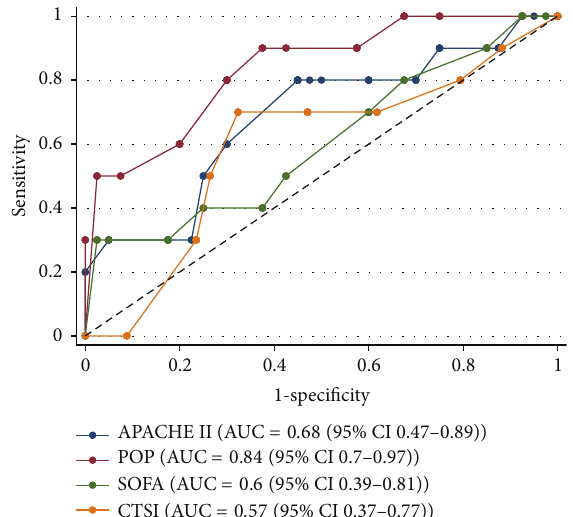
Figure 2: ROC curves for APACHE II, POP, SOFA, CTSI scores. ROC, receiver operator characteristic curve; AUC, area under curve; CI, confidence interval; APACHE, Acute Physiology and Chronic Health Evaluation; SOFA, sequential organ failure assessment; POP, pancreatitis outcome prediction; CTSI, Computed Tomography Severity